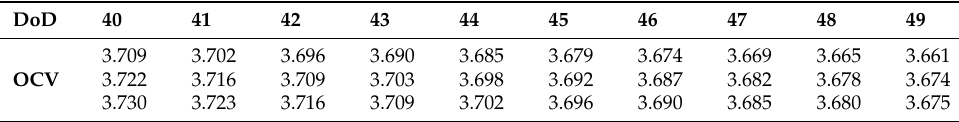
Table A5. OCV models parameters for DoD from 40% to 49%.